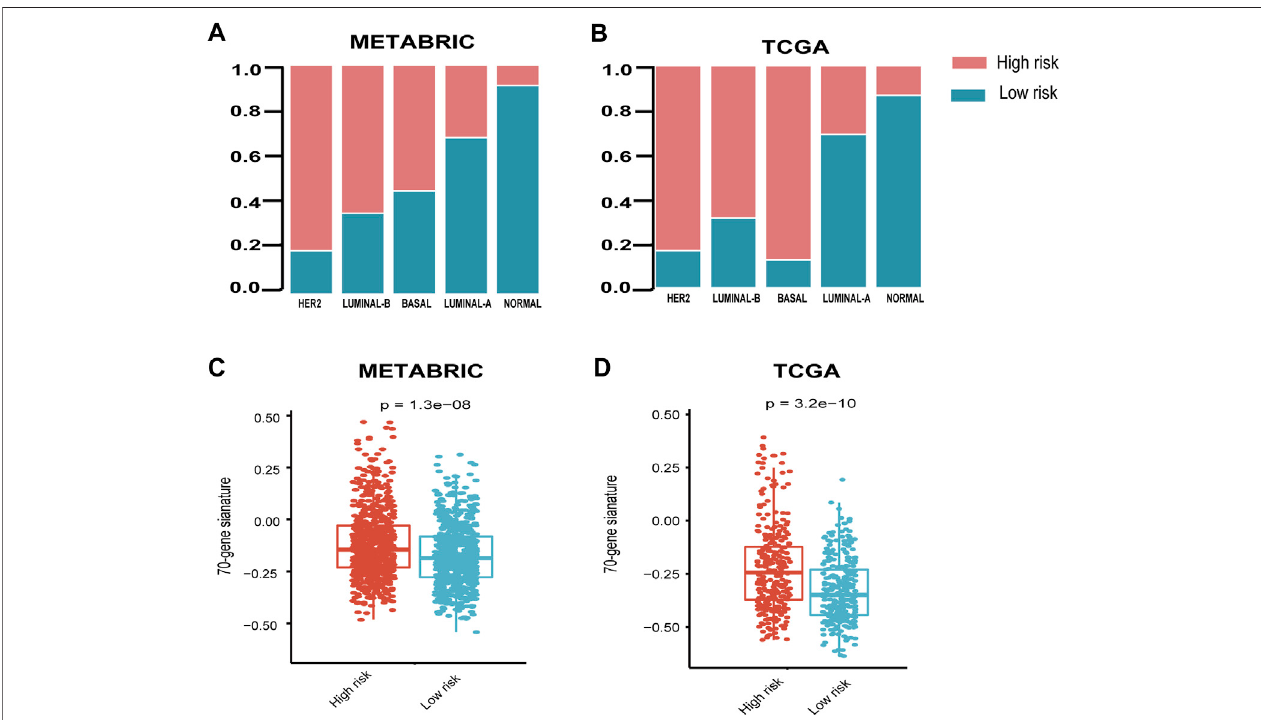
FIGURE3| Relationshipbetweenseven-immune-related-geneIRSandtheclinicopathologicalcharacteristics. (A) RelationshipbetweenIRSandPAM50subtypes in the METABRIC cohort. (B) Relationship between IRS and PAM50 subtypes in TCGA cohort. (C) Relationship between IRS and 70-gene score in METABRIC and (D) TCGA cohorts. IRS: immune risk signature; METABRIC: Molecular Taxonomy of Breast Cancer International Consortium; TCGA: The Cancer Genome Atlas; ****: p < 0.0001. The Wilcoxon rank-sum test was performed.